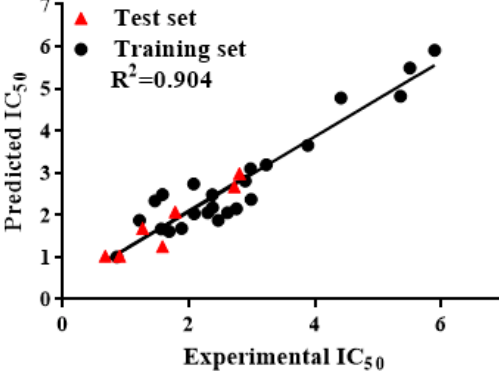
Figure 1. Experimental versus predicted IC 50 for the model.